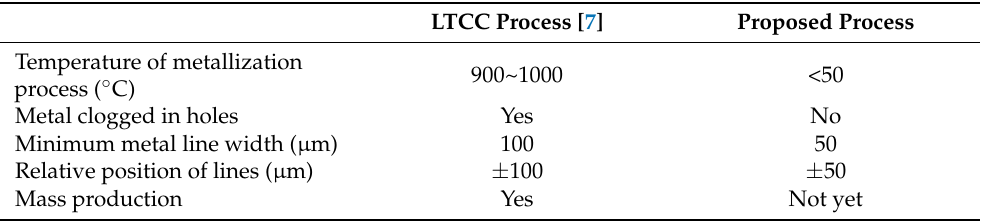
Table 9. Comparisons between the conventional LTCC process and the proposed process.